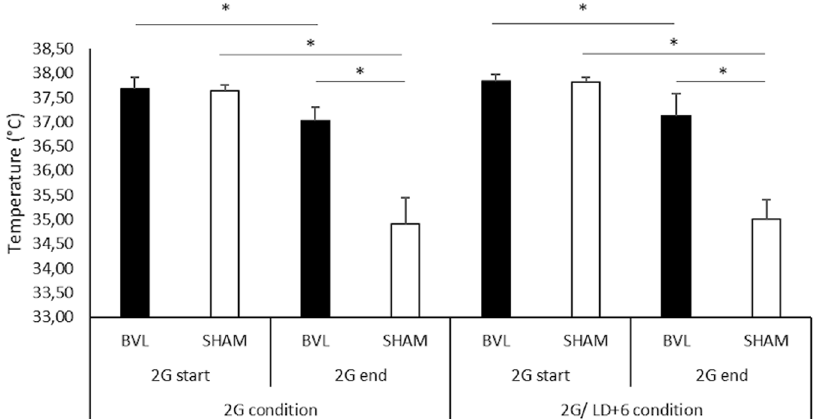
Figure 6. Fall of temperature caused by 2 G exposure. The histograms represent mean temperature from the seven 2 G pulses in BVL (black) and sham rats (white), in 2 G and 2 G/LD + 6 conditions. “2 G start” refers to the mean Tc recorded during the five minutes just before each 2 G pulse, and “2 G end” refers to the mean Tc recorded during the five minutes at the end of the 2 G